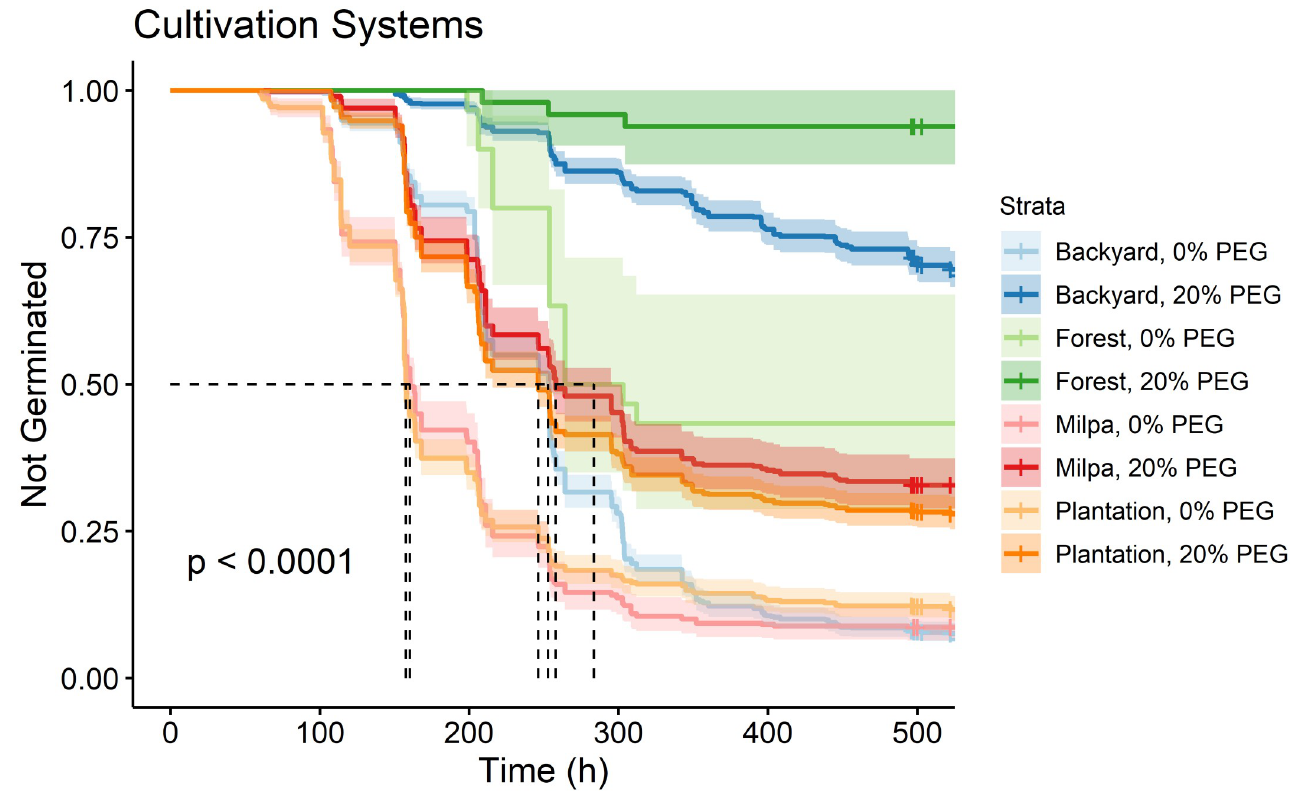
Fig 3. Kaplan-Meier estimates of survivor functions (with their 95% confidence intervals) for accessions from different cultivation systems of chile pepper in southern Mexico. The p-value from a log-rank test compares survival distributions. The dotted line represents the time to 50% germination (t 50 ). Pairwise comparisons of individual curves are presented in Table 3 in S3